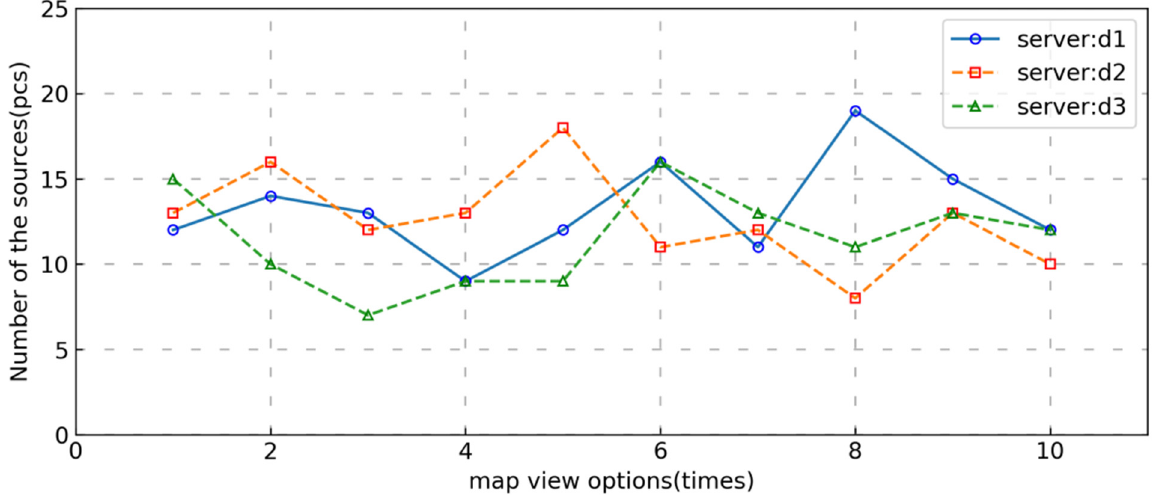
Figure 7. Load balance in tile data reading.